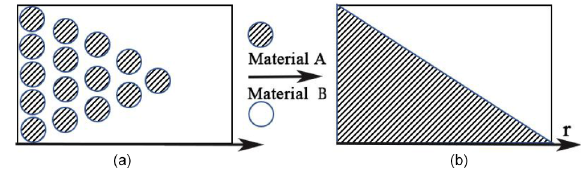
Fig. 1. Idealized functionally